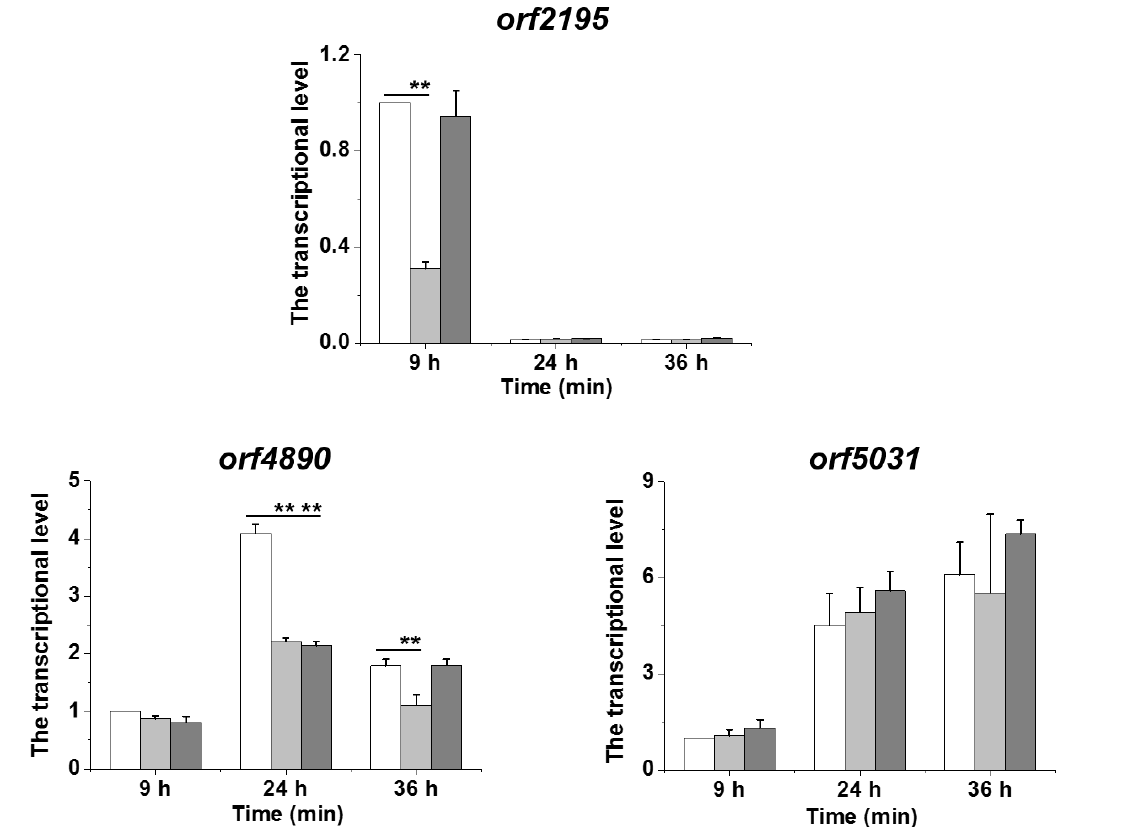
Figure 2. Transcription analysis of fatty acid hydroxylase genes ( orf2195 , orf4890 , and orf5031 ) in OH11 cultured in 1/10 TSB medium. White columns, WT; light-gray columns, ΔORF3232; and dark-gray columns, ORF3232CM. Data are presented as averages of the three independent experiments, each conducted in triplicates, with ** p < 0.01.